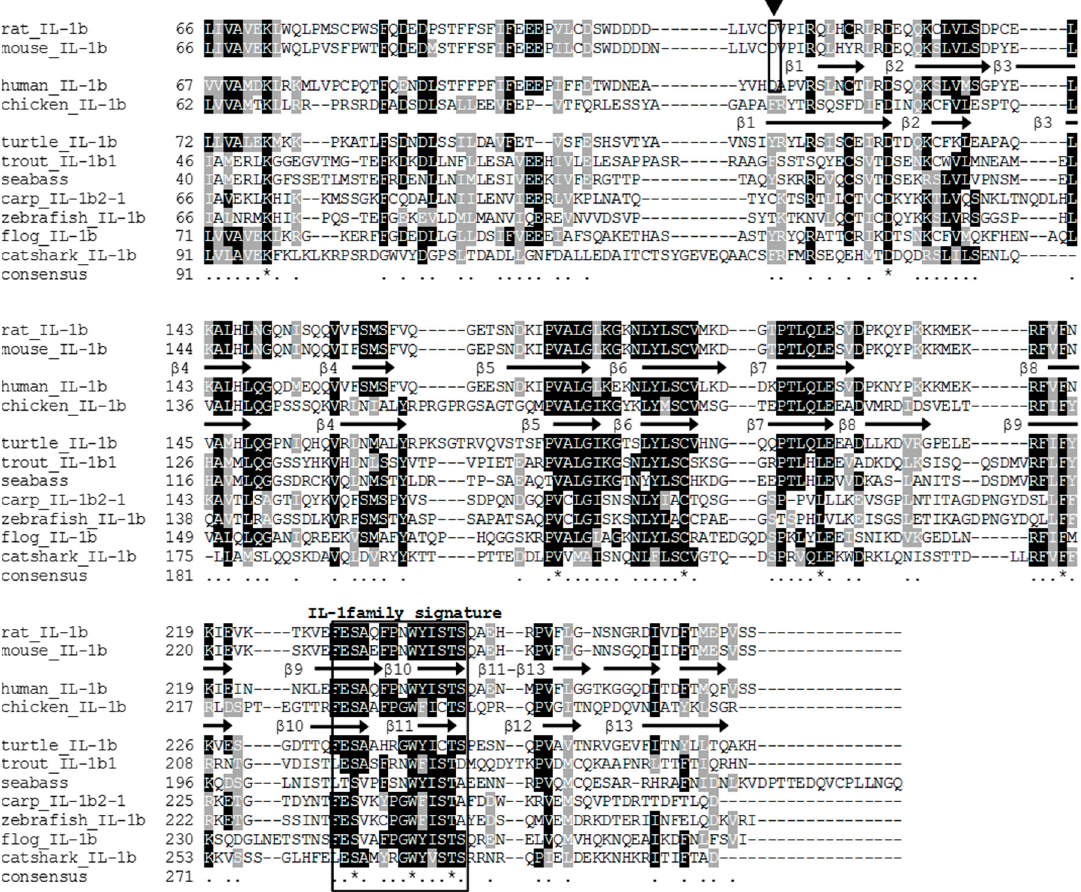
Figure 2. Multiple alignment of P. sinensis IL-1 β molecules with known IL-1 β s by ClustalW. Conserved amino acids are shaded using BOXSHADE. The IL-1 family signature is labeled above the alignment and the human IL-1 β β -sheet and predicted P. sinensis IL-1 β β -sheet is indicated with an arrow. Mammalian IL-1-converting enzyme cut site is labeled with triangle. The accession numbers of the IL-1 β sequences are as follows: NP_113700.2 (rat), EDL28238 (mouse), NP_000567 (human), NP_989855 (chicken), AFX97767.1 (turtle), CAB53541.3 (trout), CAC41006.1 (seabass), CAC19887.1 (carp), AAQ16563.1 (zebrafish), CAC85480.1 (flog), CAC09435.1 (catshark).